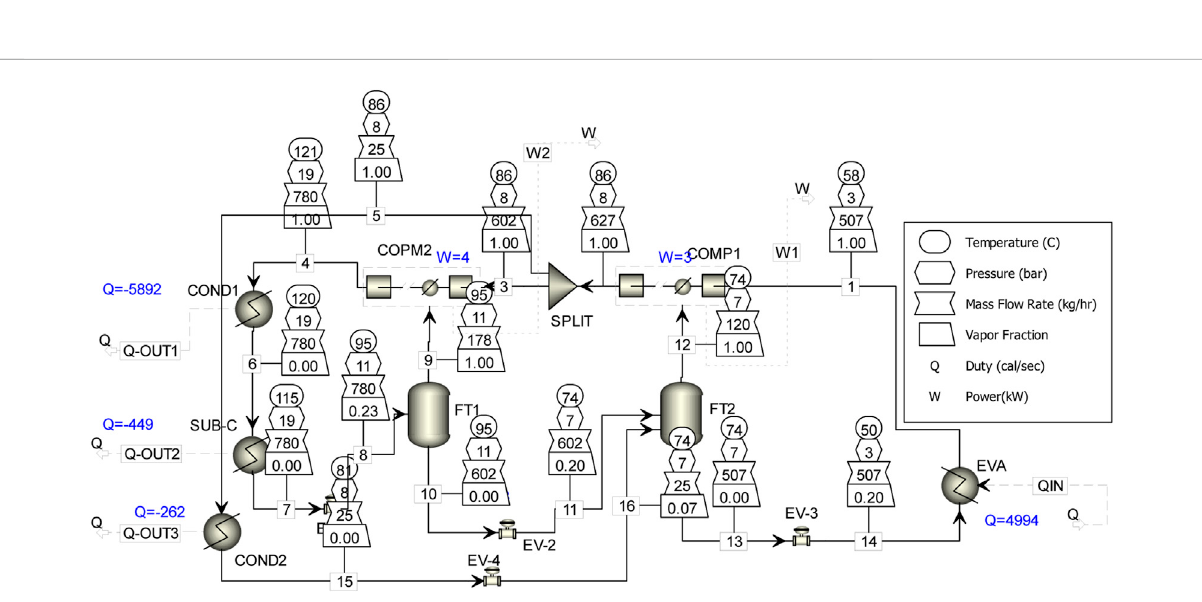
FIGURE 15 The state of each node of the model after the